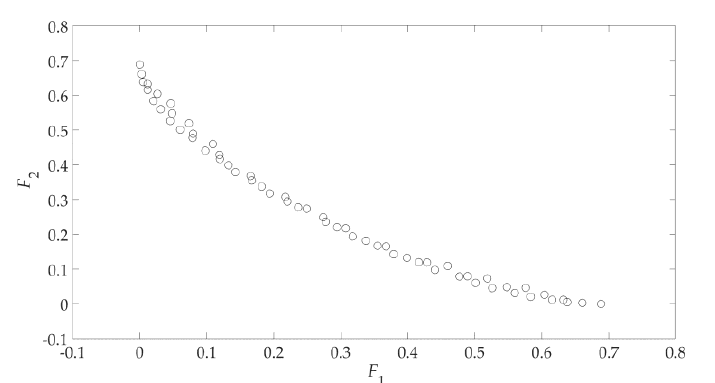
Figure 3. The Pareto front boundary in the objective space.